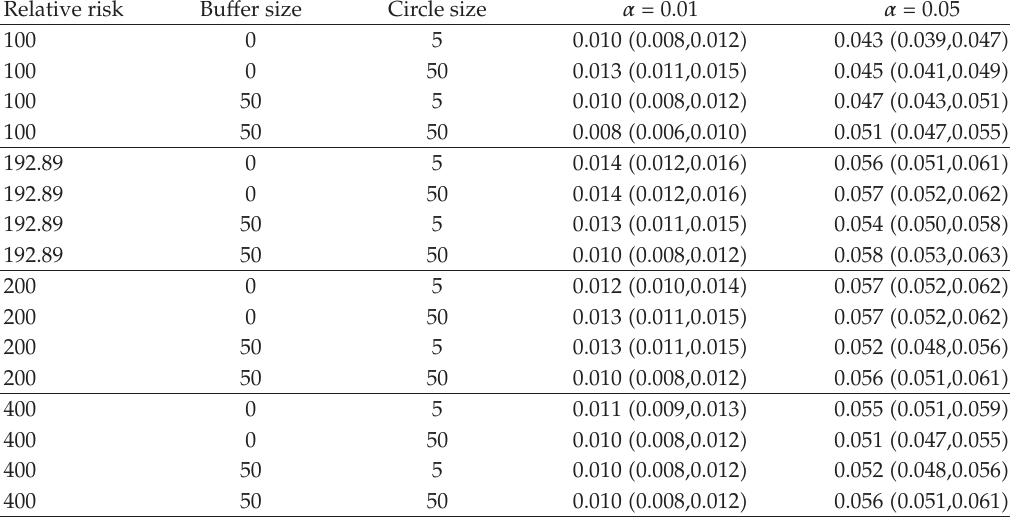
Table 2: The estimated type I error probabilities for the second most likely cluster when there is only one true cluster in Grand Isle county, with 95% confidence intervals. Di ff erent relative risks were used, two di ff erent bounds on the maximum window size as well as two di ff erent bu ff er sizes defining the number of neighboring counties that were removed together with the counties in the most likely cluster detected. The circle size is the maximum geographic size of the scanning window defined in terms of a percentage of the total populations.